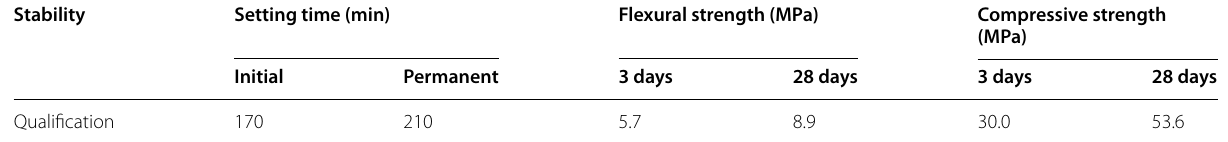
Table 1 Basic properties of the cement